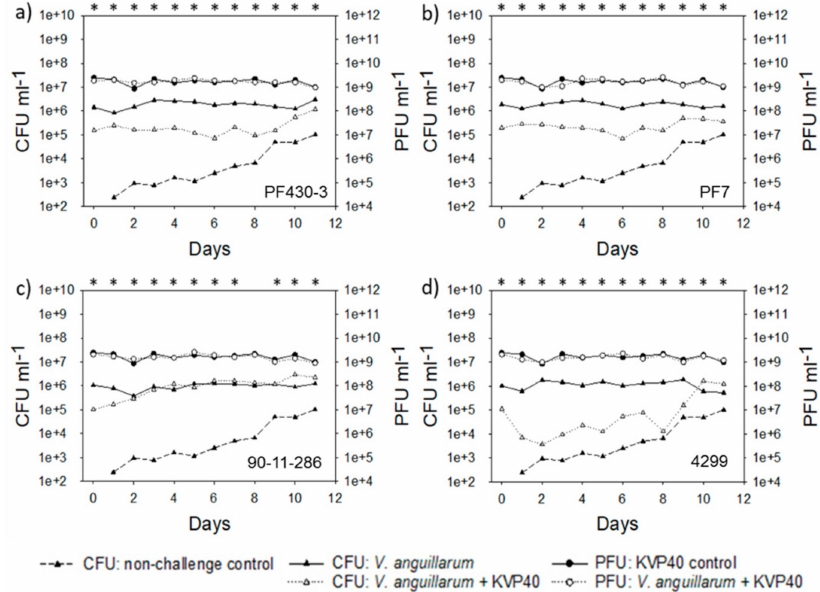
Figure 7. Bacterial abundance (CFU mL − 1 ) and phage abundance (PFU mL − 1 ) in cod challenge trial 2: ( a ) strain PF430-3; ( b ) strain PF7; ( c ) strain 90-11-286; ( d ) strain 4299. Significant difference in CFU between cultures “CFU: V. anguillarum ” and “CFU: V. anguillarum + KVP40” for individual time points is indicated by *.